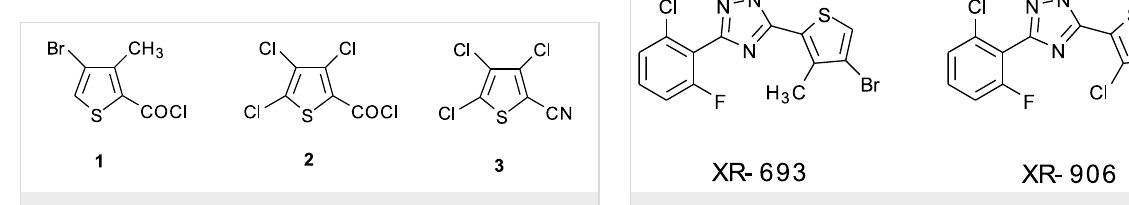
Figure 1: Thiophene structures 1 , 2 , and 3 . Figure 2: XR-693 and